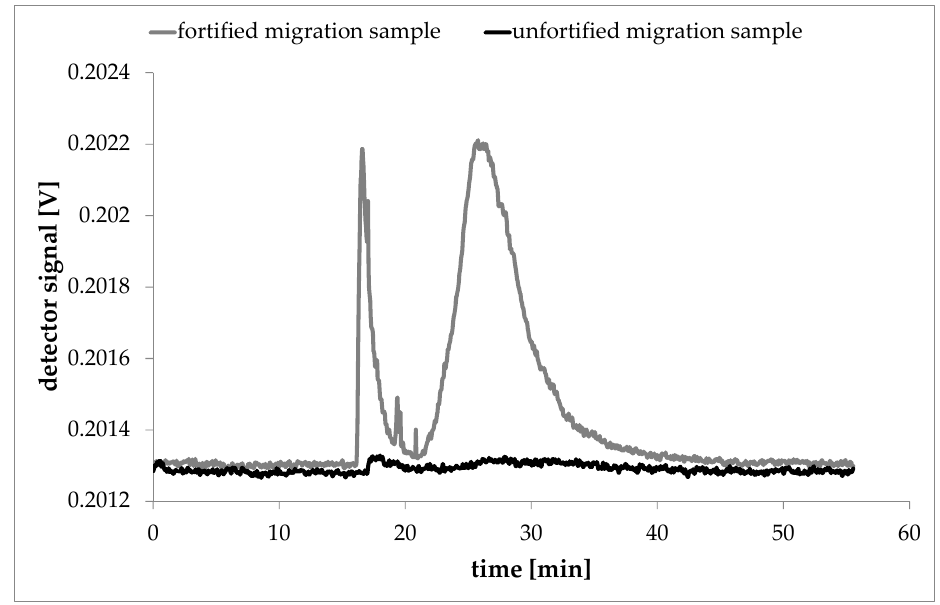
Figure 8. AF4 fractograms from a 6% laponite in LDPE migration solution before and after spiking to 500 ng/mL laponite.